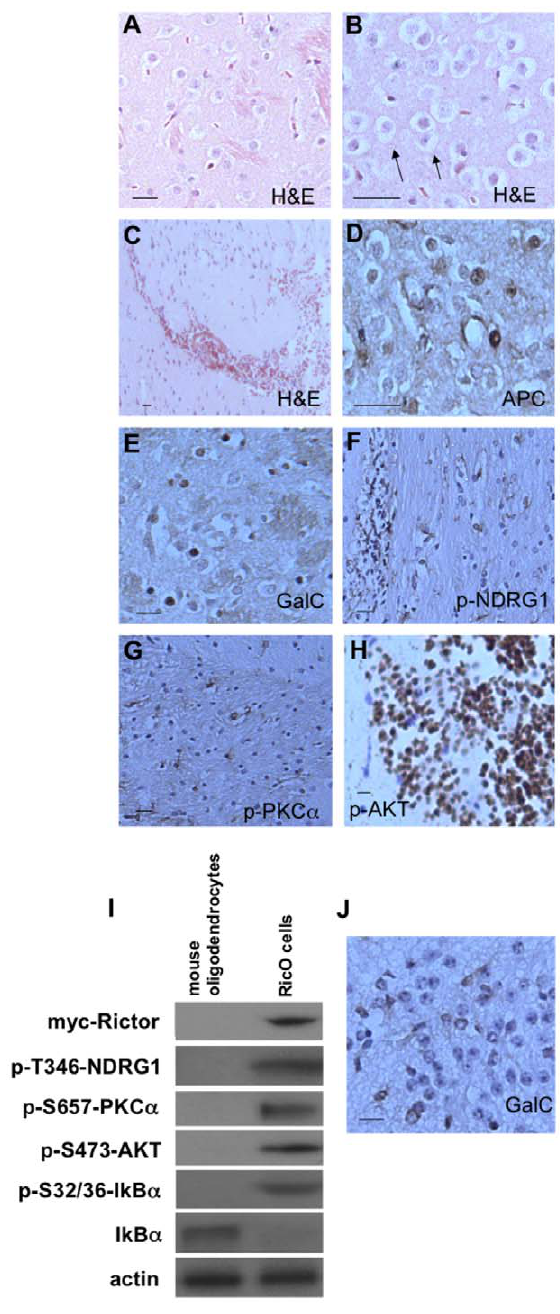
Figure 2. Gliomas in GFAP-Cre/Rictor loxp/loxp transgenic mice. (A) Low magnification of H & E-stained multifocal gliomas. (B) H & E-stained oligodendroglial tumor cells. (C) Representative gliomas displaying chicken wire-like vascularity observed in oligodendrogliomas. (D&E) Oligodendroglial tumor cells immunoreactive for APC and GalC, respectively. (F–H) Sections were stained with antibodies to phospho- T 346 -NDRG1, phospho-S 657 -PKC a and phospho-S 473 -AKT, respectively and demonstrated increased staining in oligodendroglial cells. In A–H, scale bar; 20 m m. (I) Increased mTORC2 signaling determined by immunoblot of Ric0 oligodendroglial cell line established from a newborn GFAP-Cre/Rictor loxp/loxp glioma. The Rictor transgene was detected using antisera specific for human Rictor. (J) GalC immunore- active Ric0 cells demonstrating oligodendroglial lineage. Scale bar; 20 m